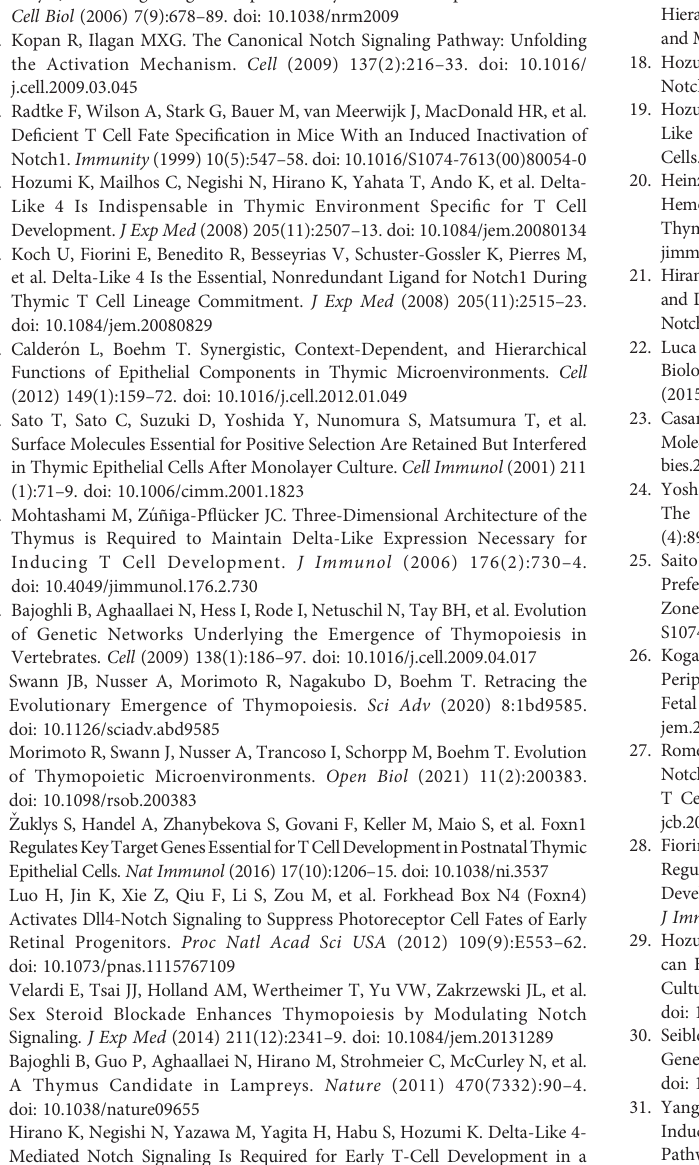
Supplementary Figure 2 | The numbers of thymocyte subsets. Thymic cellularity (mean ± SD) of thymocyte subsets (CD4 + CD8 + , DP; CD4 + CD8 - , 4SP; CD4 - CD8 + , 8SP;CD4 - CD8 - ,DN;CD19 + ,CD19)derived fromthe micein Figure2 wereshown. **P<0.01, *P<0.05 by Student t -test. Supplementary Figure 3 | Bone marrow (BM) chimera experiments. The experimental schemes for BM chimeras are shown for Figures 4A and 5B . Supplementary Figure 4 | Mature T cells from Notch1-de fi cient(Italic) BM cells in the lymph nodes of iD1 and iD4 mice. All data were obtained from inguinal lymph nodes of the BM chimera, as shown in Figure 5 . (A) Flow cytometric analysis of inguinal lymph nodes from secondary BM chimeric mice. Numbers in the pro fi les indicate the relative percentage of CD45.1 + or GFP + cells (internal control, Int. cont) (left panels, B220 vs. CD3) and CD45.1 + CD3 + or GFP + CD3 + cells (right panels,